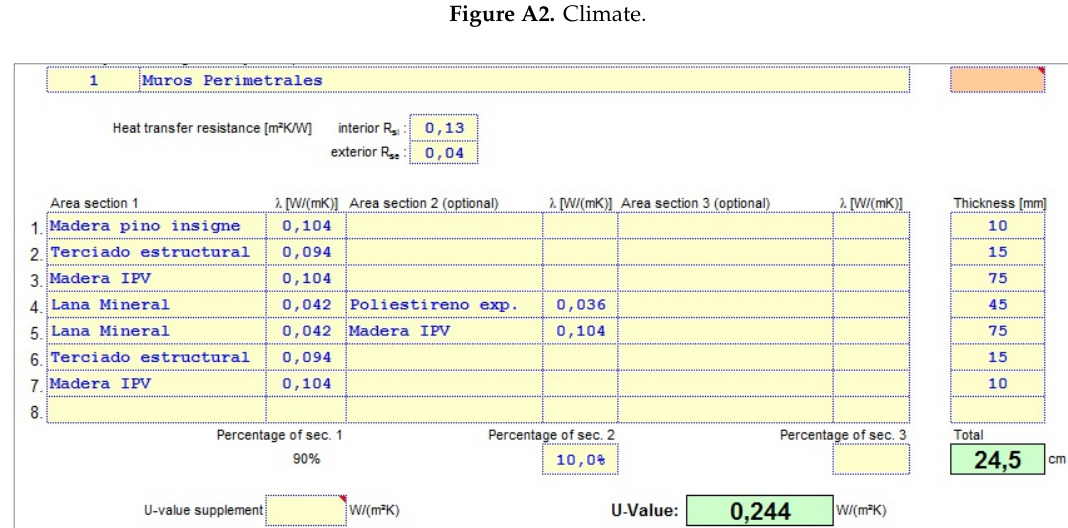
Figure A2. Climate. Figure A2. Climate.